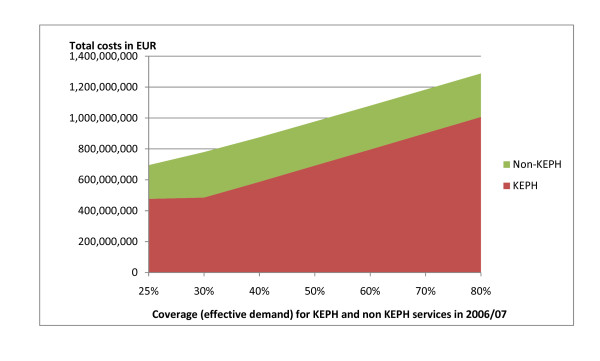
Cost Responsiveness.